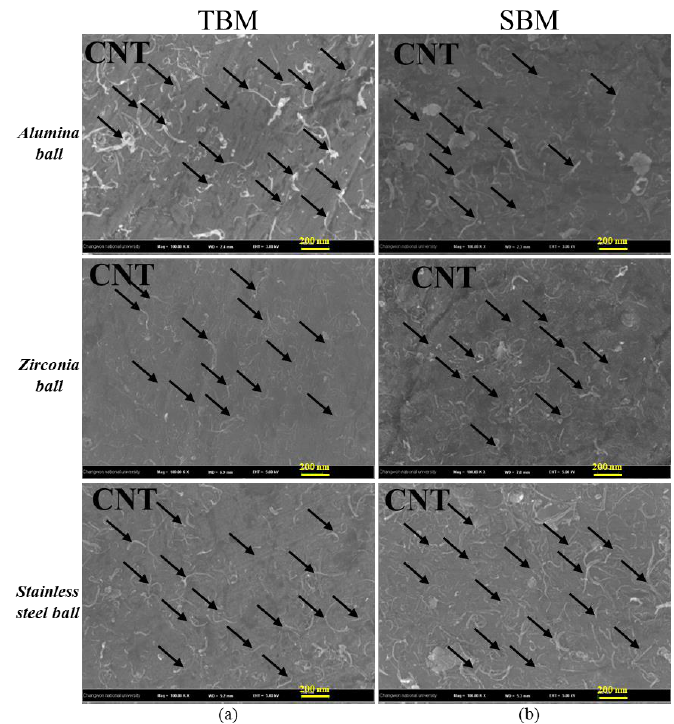
Figure 8. FESEM images (100,000×) of Cu/CNT nanocomposites for 12 h at 100 rpm in both mills ( a ) TBM and ( b ) SBM with three different milling media.